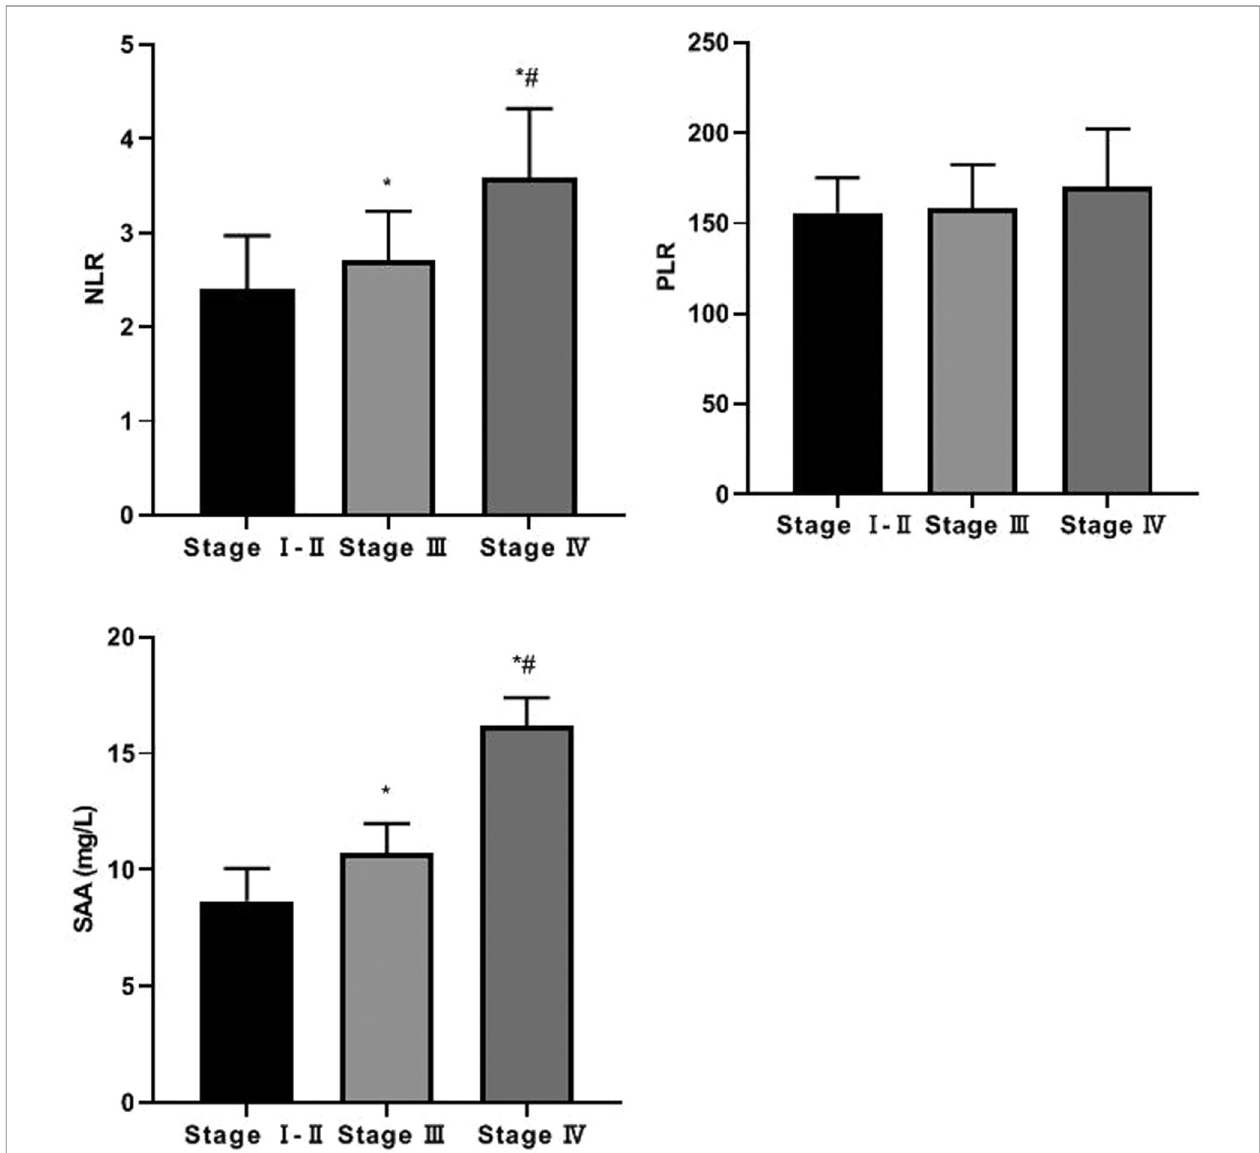
FIGURE 1 | Serum NLR, PLR and SAA levels of CRC patients in different stages Compared with Stage I – II, * p <0.05; Compared with stage III, # p <0.05.